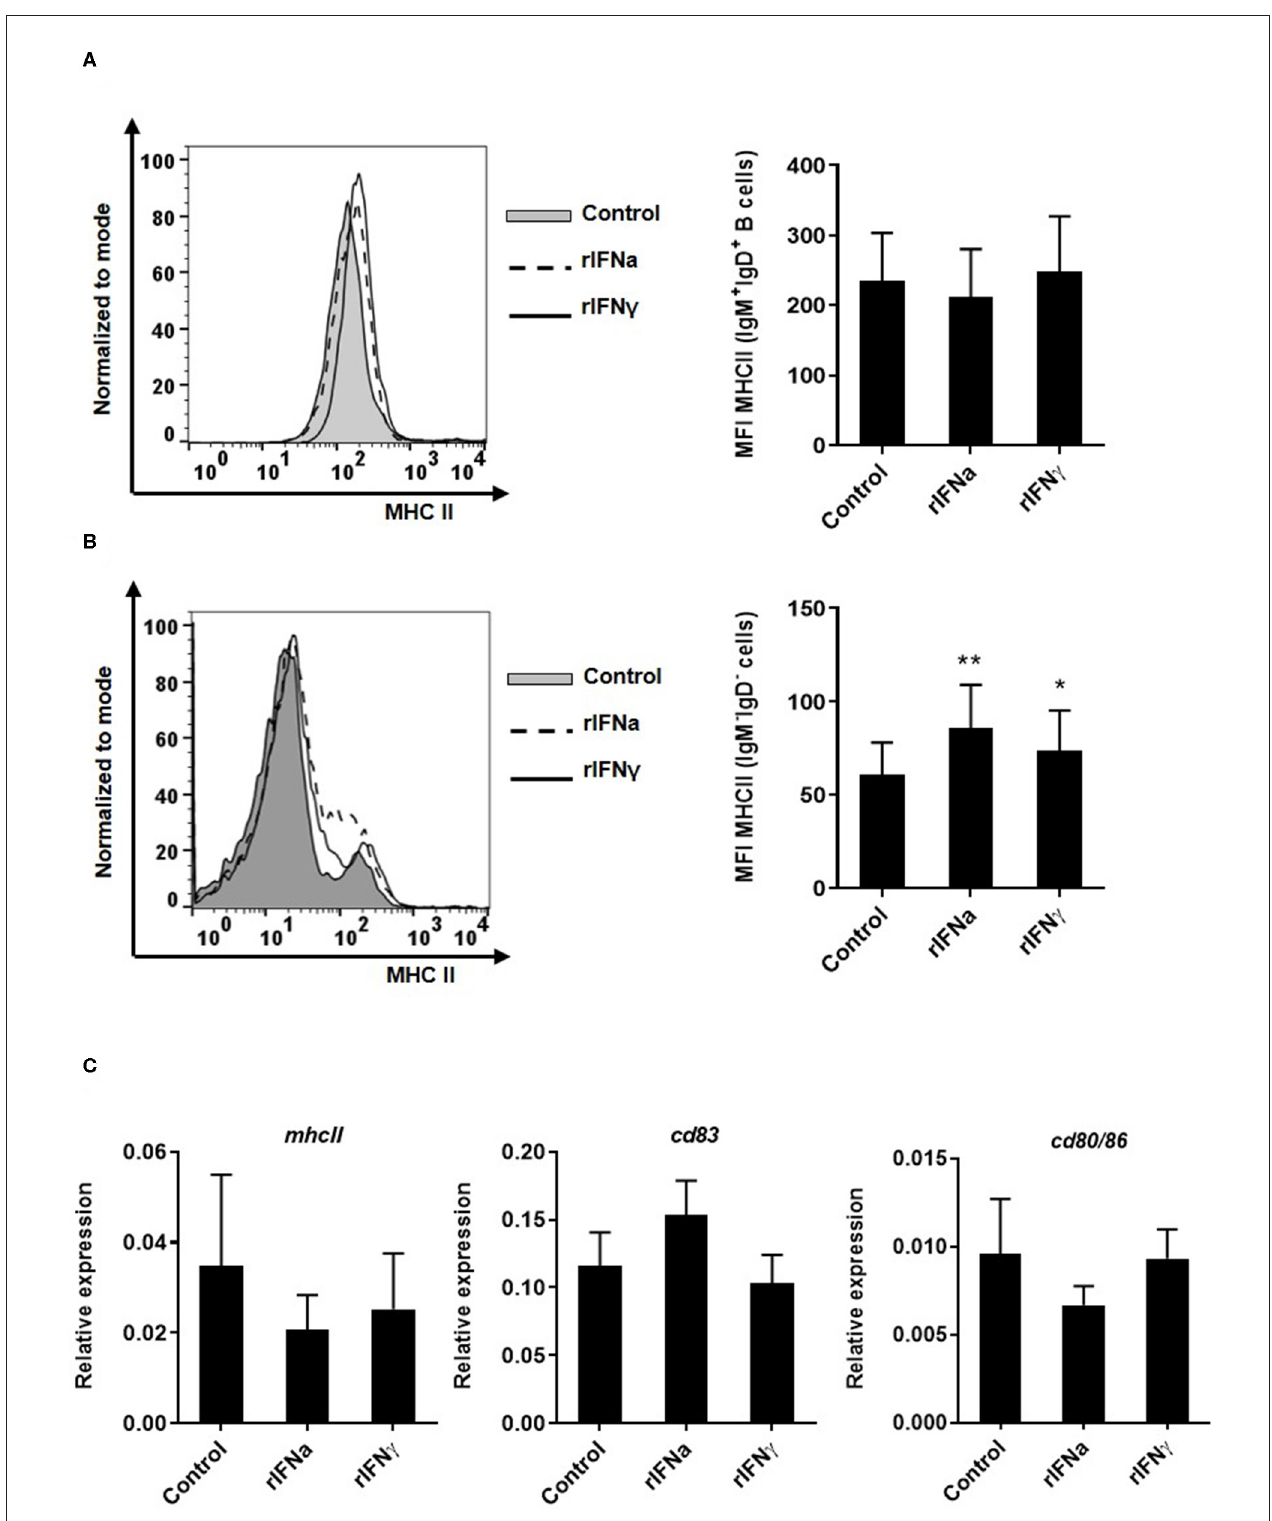
FIGURE 6 | Effect of type I and type II IFNs on the antigen-presenting capacities of blood cells. PBLs were incubated with 50ng/ml rIFNa, 20ng/ml rIFN γ or media alone (control) for 72h at 20 ◦ C. The level of MHC-II surface expression on IgM + IgD + B cells and IgM − IgD − cells was then measured via flow cytometry using a